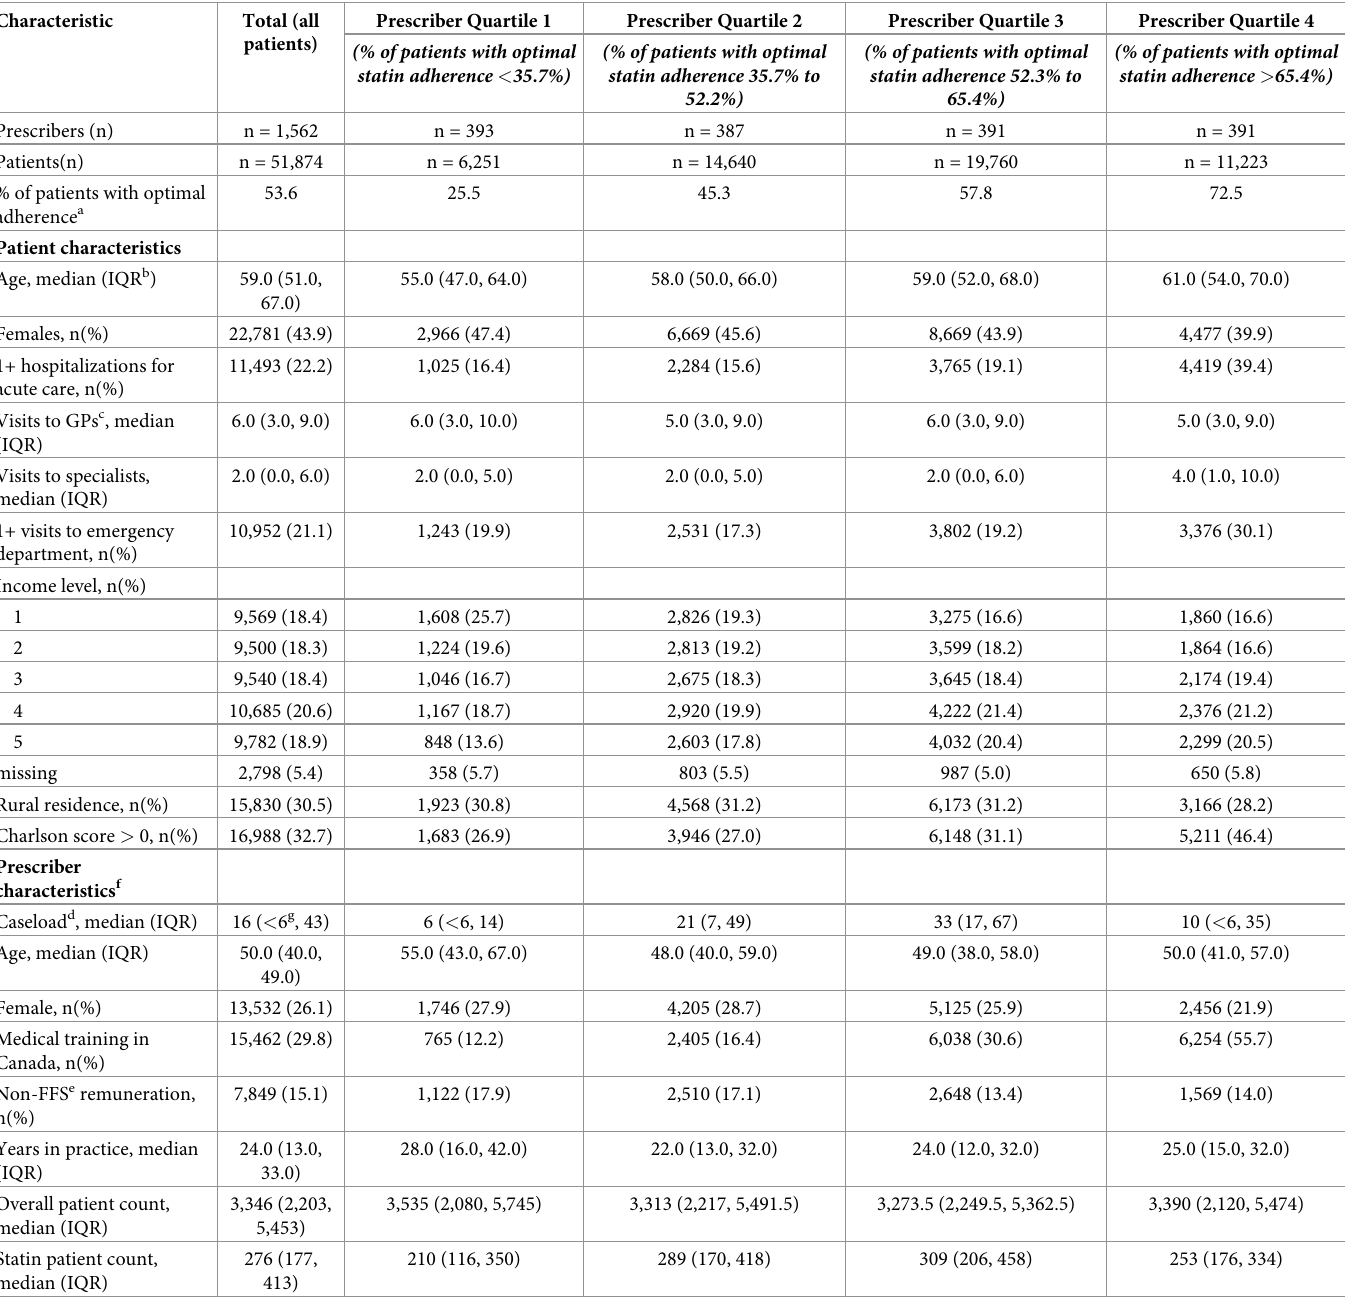
Table 1. Patient and prescriber